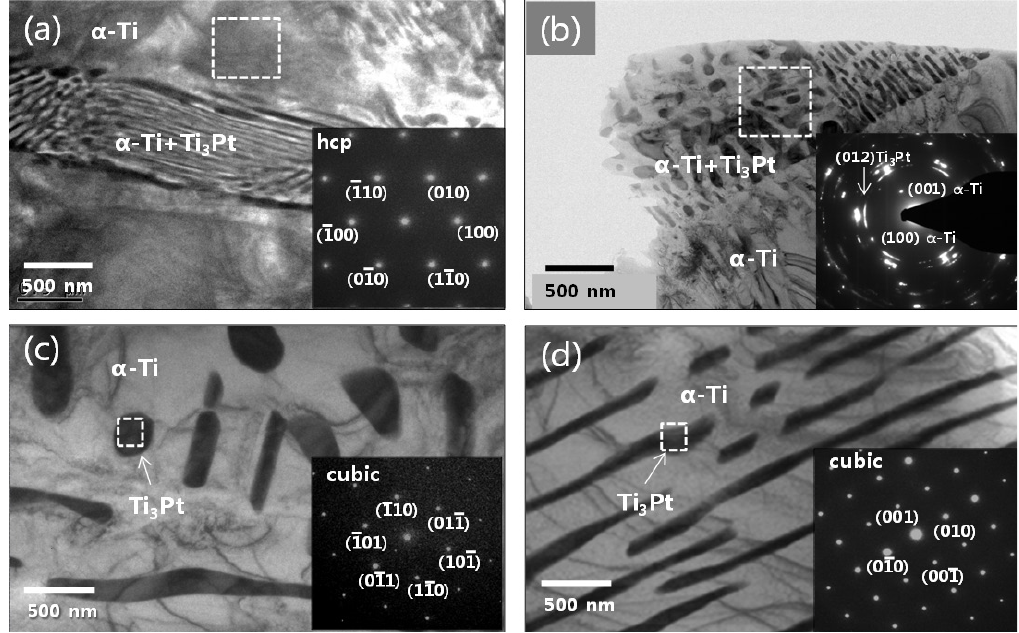
Figure 3. TEM images and selected area energy diffraction (SAED) patterns (inset)